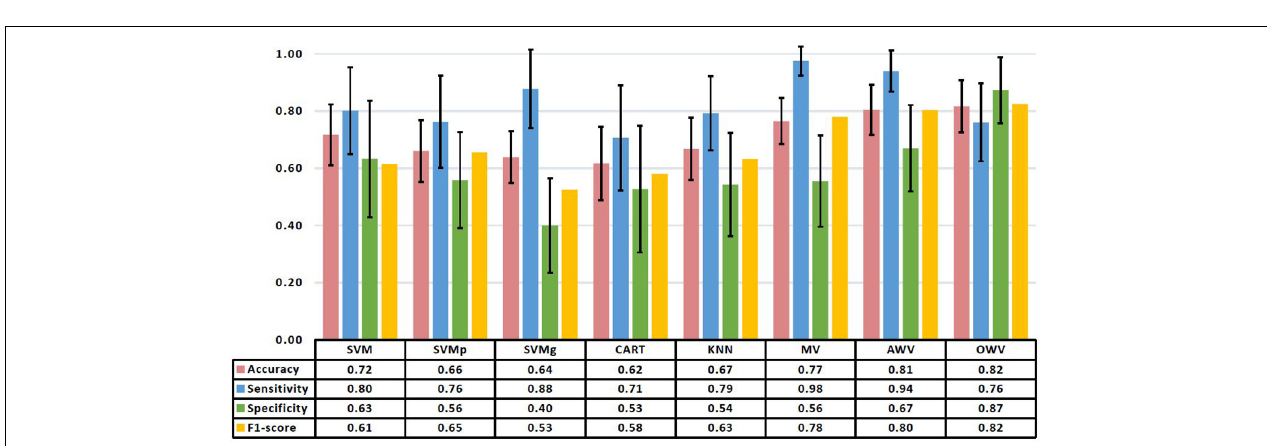
FIGURE 5 | Mean and standard deviation of the performance metrics on the test set of the different classification methods. The table shows the mean values. AWV, accuracy weighted voting; CART, classification and regression trees; KNN, K-nearest neighbors; OWV, optimum weighted voting; SVM, support vector machine; SVMg, support vector machine Gaussian kernel; SVMp, support vector machine polynomial kernel.